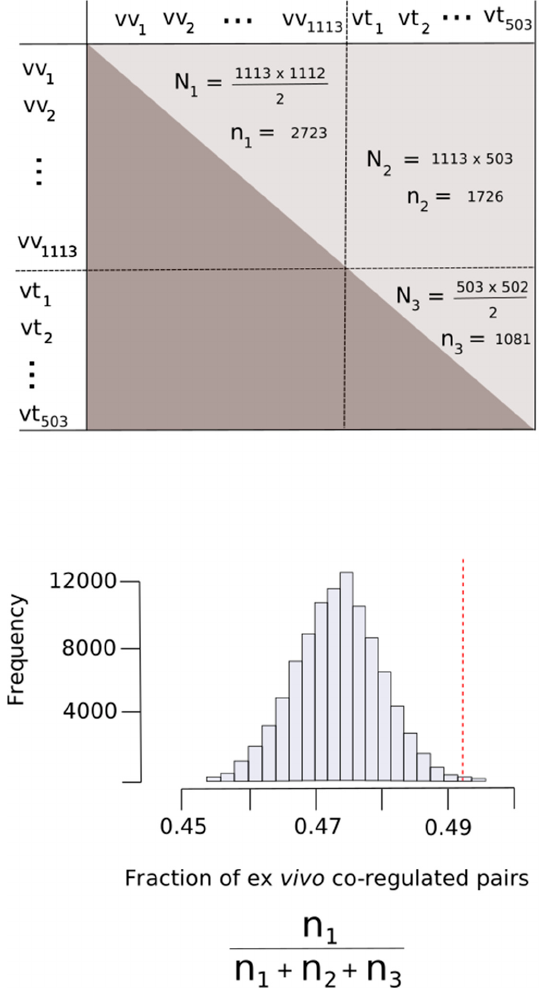
Figure 9. Proteins oxidized ex vivo are co-regulated more often than expected by chance. All of the potential pairs of proteins oxidized ex vivo (vv) and in vitro (vt) were considered. As the pair formed by a given protein with itself has no meaning in our context, the main diagonal of the matrix corresponding to this cartesian product was disregarded (upper panel). Given that the pair (x, y) is the same as the pair (y, x), our matrix is an upper triangular matrix. N 1 , N 2 and N 3 represent the number of elements from this matrix formed by pure ex vivo (vv, vv), mixed (vv, vt) and pure in vitro (vt, vt) pairs, respectively. On the other hand, n 1 , n 2 and n 3 correspond to the numbers of these pairs observed in our dataset. In the bottom panel is the distribution of the fraction of ex vivo co-regulated pairs expected when the pairs were sampled randomly. The vertical red dashed line indicated the actual fraction of the ex vivo co-regulated pairs observed.